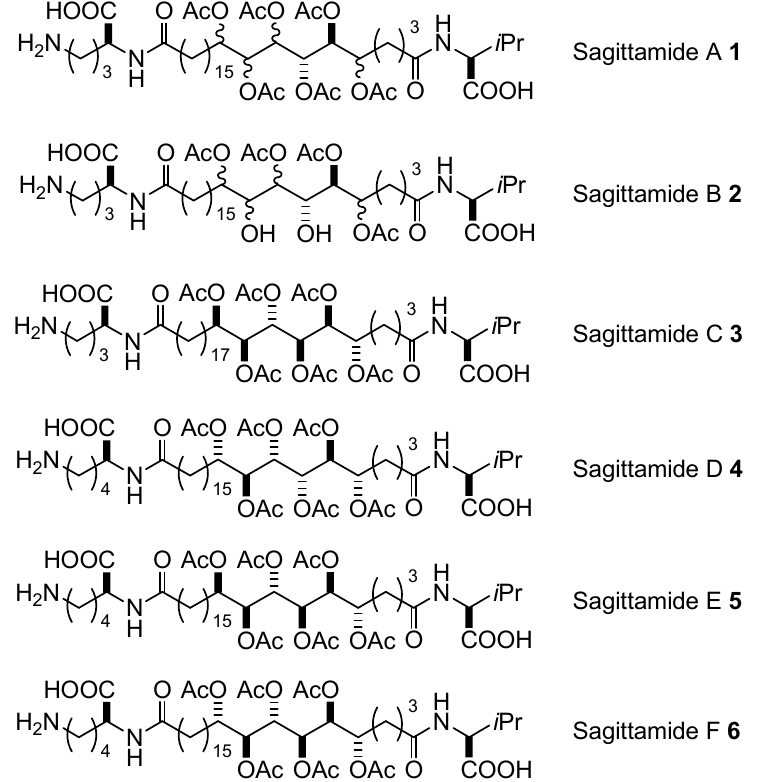
Figure 1. Structures proposed for Sagittamides A–F 1 – 6 .